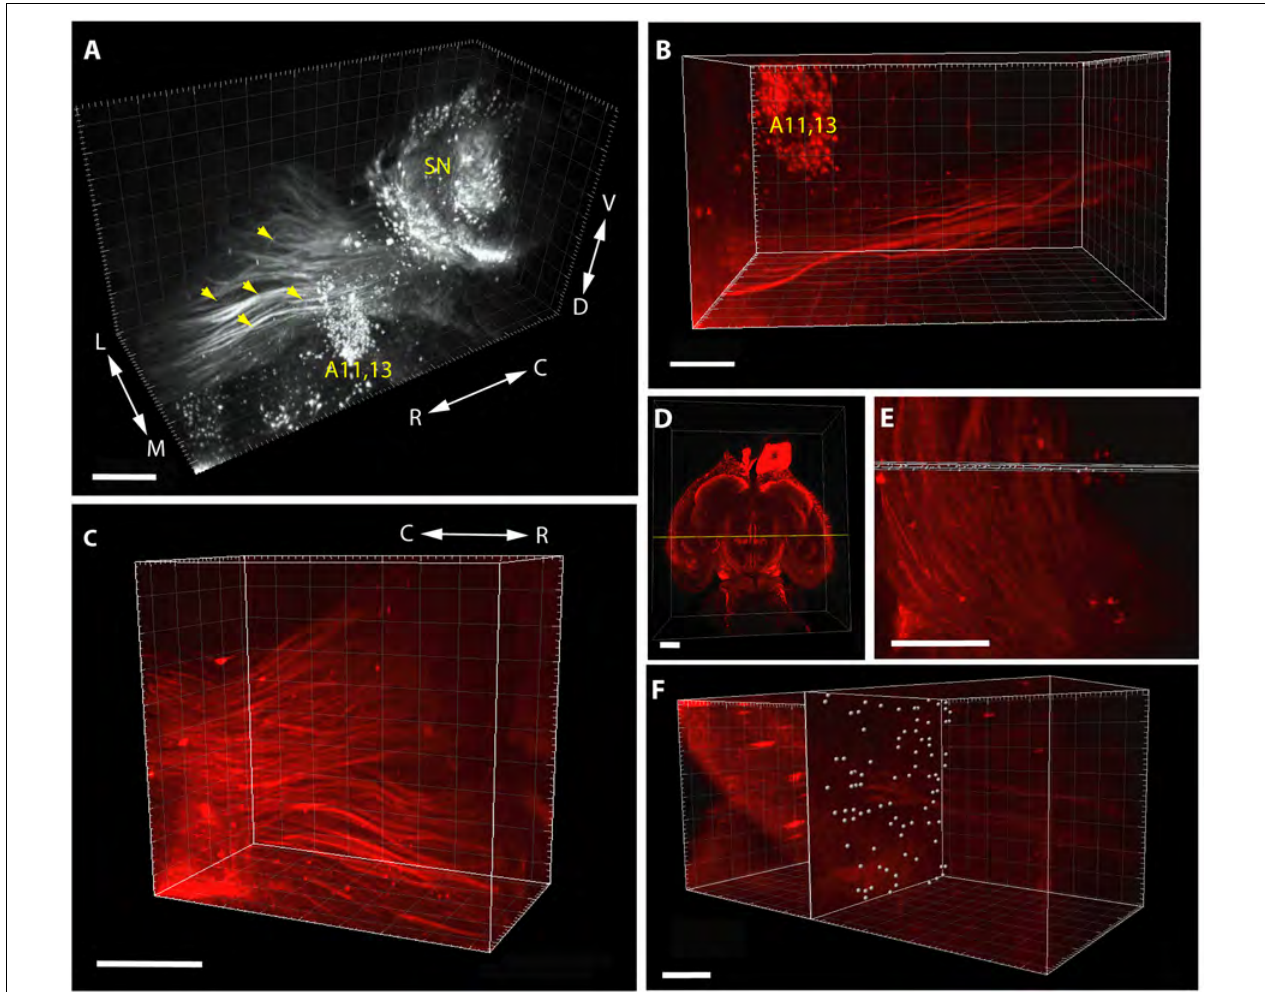
FIGURE 2 | Segmentation and volume rendering of catecholaminergic diencephalic and mesencephalic cell groups together with the fascicles of mesotelencephalic dopaminergic pathway, using the iDISCO method with IMARIS, version 8.3.0, on images from representative control brain specimens immunostained for TH. (A) Medial view of the SN, A11–13 and the mesotelencephalic fiber tract (enhanced grayscale image). (B) Dorsal view of the segmented original (far-red fluorescent) image of the mesotelencephalic tract passing by the A11–13 cell group. (C) Oblique rostrolateral view of the mesotelencephalic pathway, note the presence of robust fascicles. (D) Overview image showing the position of the measuring slab (rectangular cuboid) laid at the rostral limit of A11–13, from a ventral aspect. (E) Enlarged view of the measuring slab following the automated generation of the array of voxels (measuring spheres) at the intersections with the fascicles of the mesotelencephalic tract. (F) Rostrolateral view of the measuring slab containing the automatically generated measuring spheres at the intersection windows, used for particle counting. Scale bars: (A) 500 µ m, (B,C,E,F) : 200 µ m, (D) : 1,000 µ